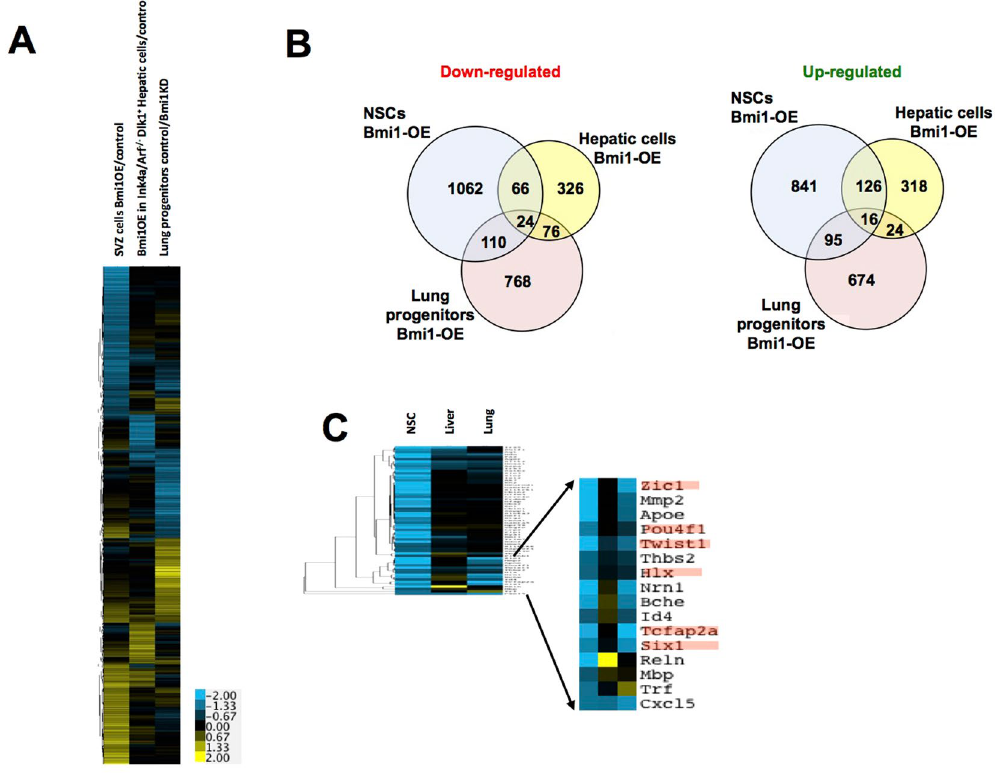
Figure 3. Effect of elevated Bmi1 expression in aNSCs, hepatic precursor cells, and lung stem cells. ( A ) Hierarchical clustering of 4202 genes showing altered expression of at least 1.5 fold in at least one of the three data sets indicated. ( B ) Overlap among genes up- or down-regulated by at least 1.5 fold in the indicated data sets. ( C ) Hierarchical clustering was performed on gene expression changes caused by elevated Bmi1 levels in aNSCs, hepatic precursor cells, and lung stem cells using 64 genes down-regulated at least 2 fold in aNSCs overexpressing Bmi1 and belonging to the GO category of nervous system development. The expanded region shows a cluster of genes most of which are also down-regulated in lung stem cells. Highlighted genes encode known and probable transcription